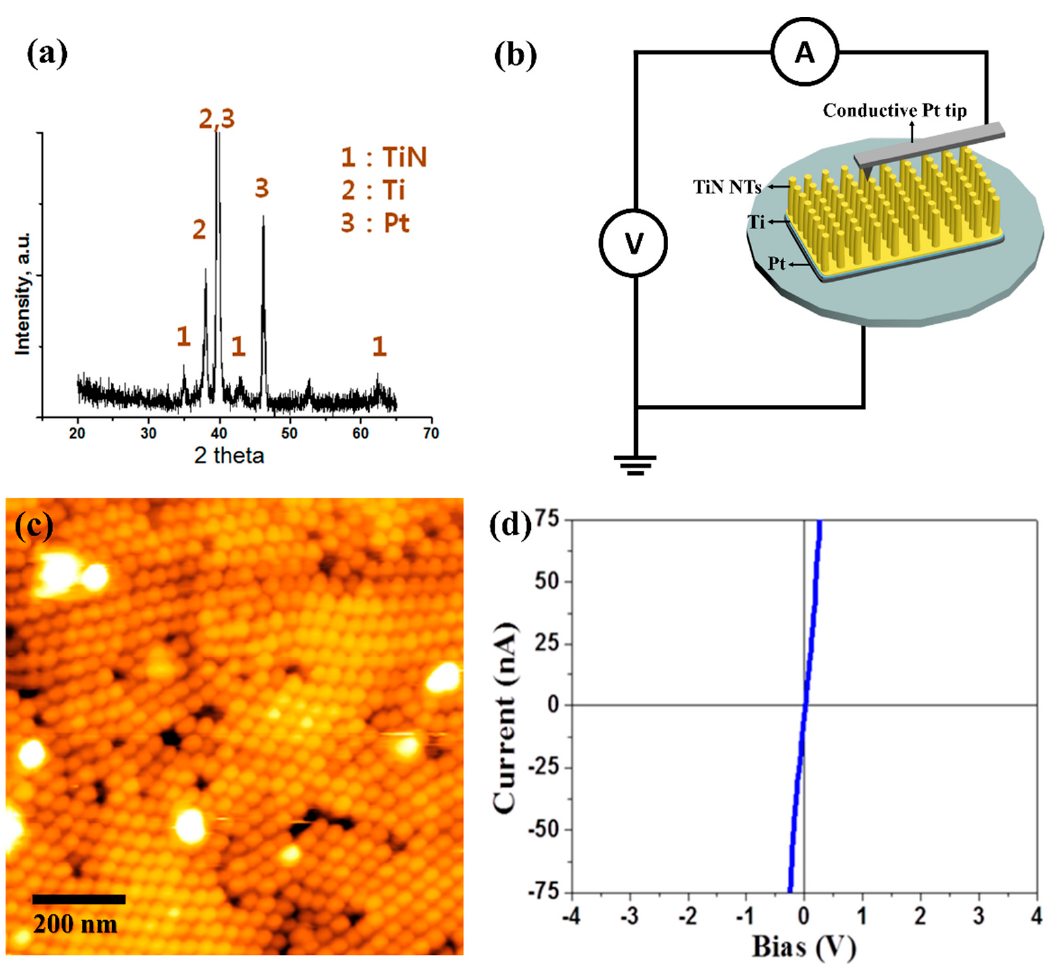
Figure 5. Analysis of TiN NTs / Ti / Pt samples ( a ) XRD, ( b ) schematic of C-AFM setup, ( c ) AFM height image, and ( d ) local I-V curve by C-AFM.